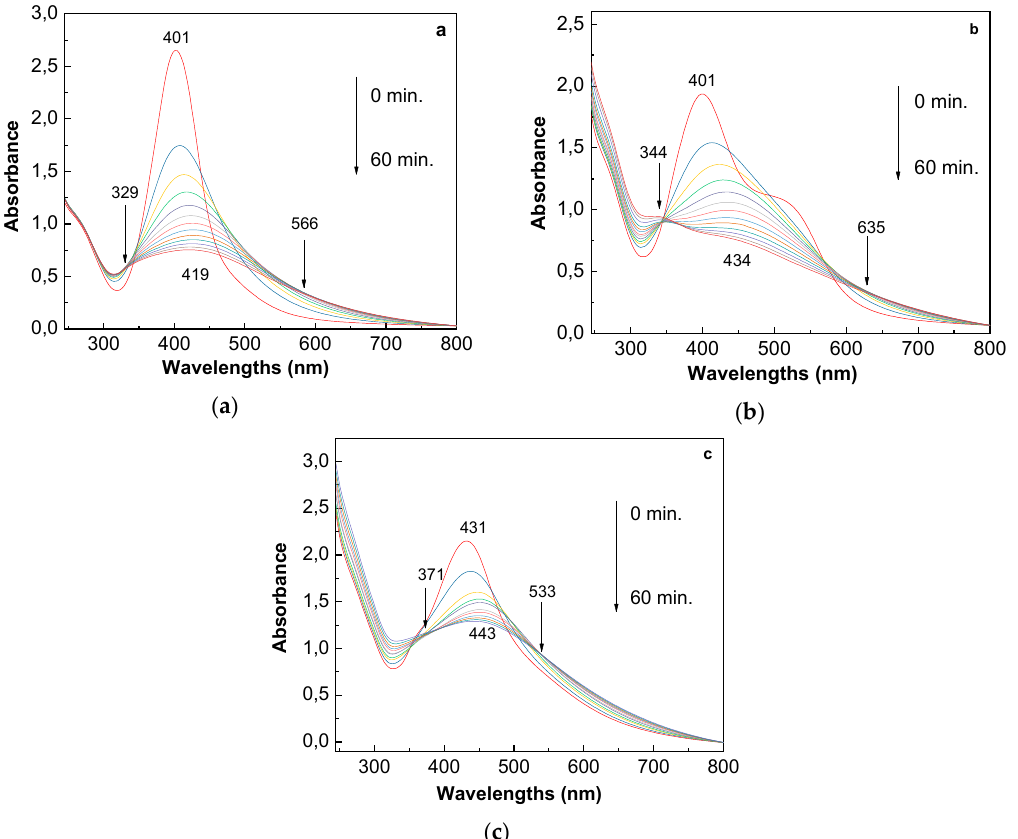
Figure 5. UV-VIS spectra of the ALA solution in the presence of excipients (commercial product marketed under the name Cerebinox) and Ag nanoparticles with a size of 5 nm, having an analyte concentration equal to 0.25 mg/mL ( a ) and 1 mg/mL ( b ), and their changes at exposure to UV light. Figure ( c ) shows the UV-VIS spectra of the Cerebinox solution with a concentration of 1 mg/mL in the presence of Ag nanoparticles with a size 10 nm and its change at exposure to UV light. The three samples' UV-VIS spectra were recorded at intervals of 5 min of exposure to UV light, for 60 min. Figure 5b highlights that, in the case of the Cerebinox solution with a concentration of 1 mg/mL, prepared in the presence of Ag nanoparticles with a size of 5 nm, the UV-VIS spectrum shows an